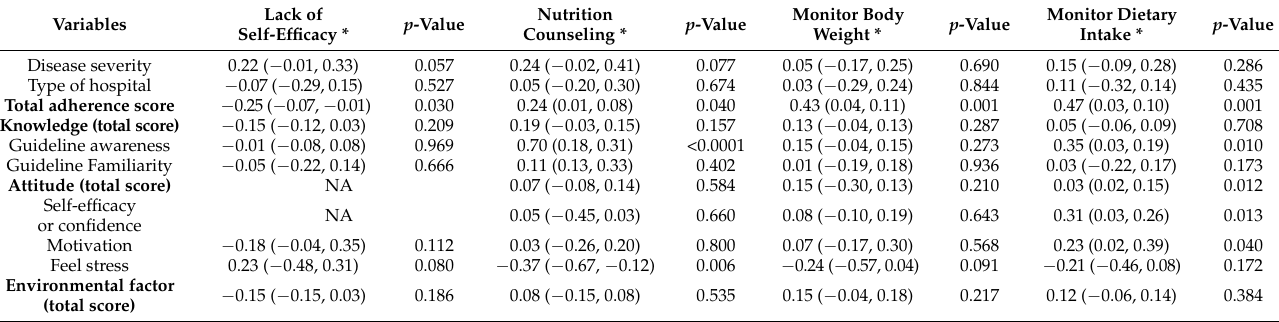
Table 4. Adjusted multivariate regression coefficient (ß) and 95% confidence intervals (CIs) of barriers of nutrition practice behaviors of COVID-19